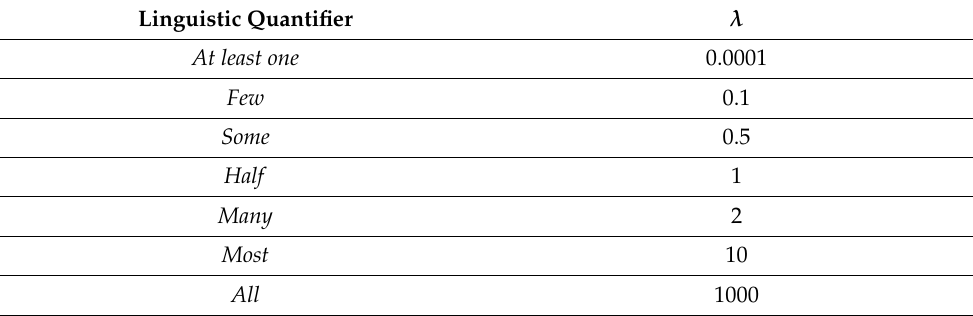
Table 2. Linguistic quantifiers with their associated parameters λ